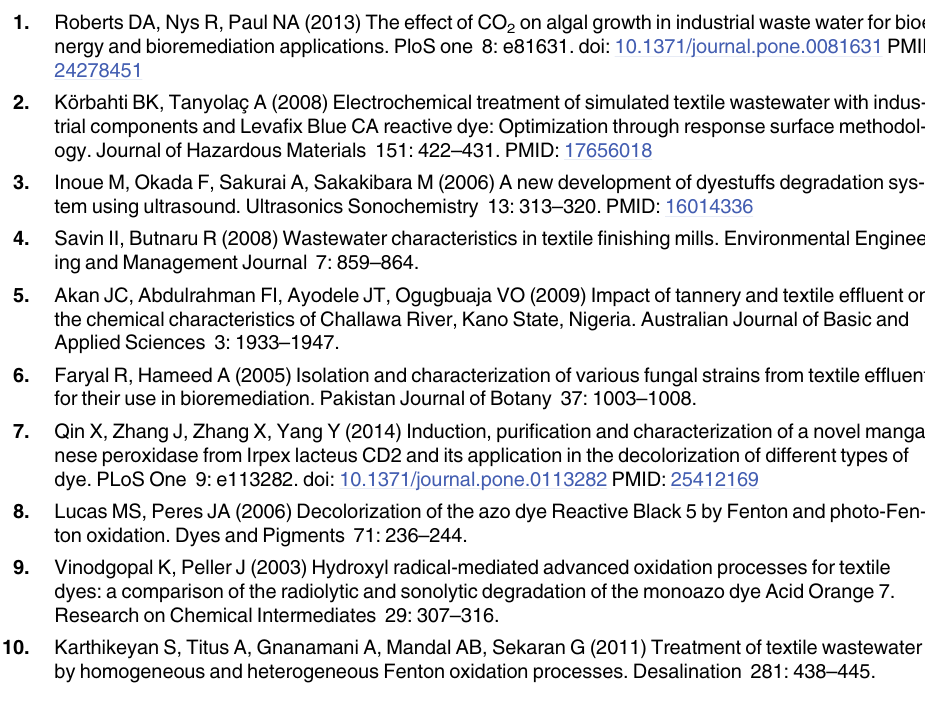
S1 Fig. Process flow diagram for the synthesis and application of